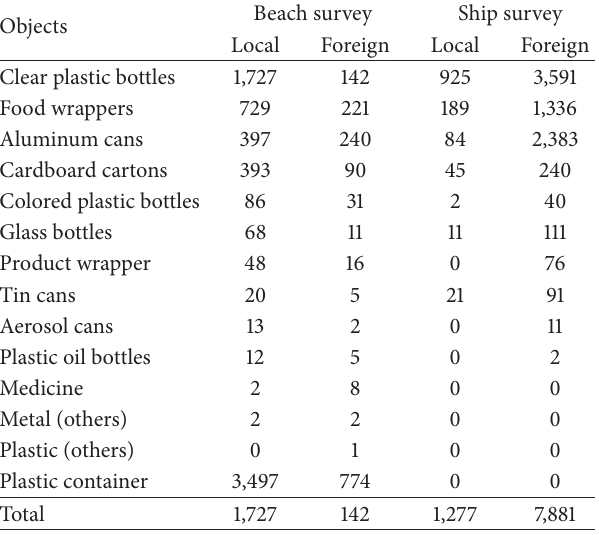
Table 8: Number of objects (number, items ) origins found at beach and ship